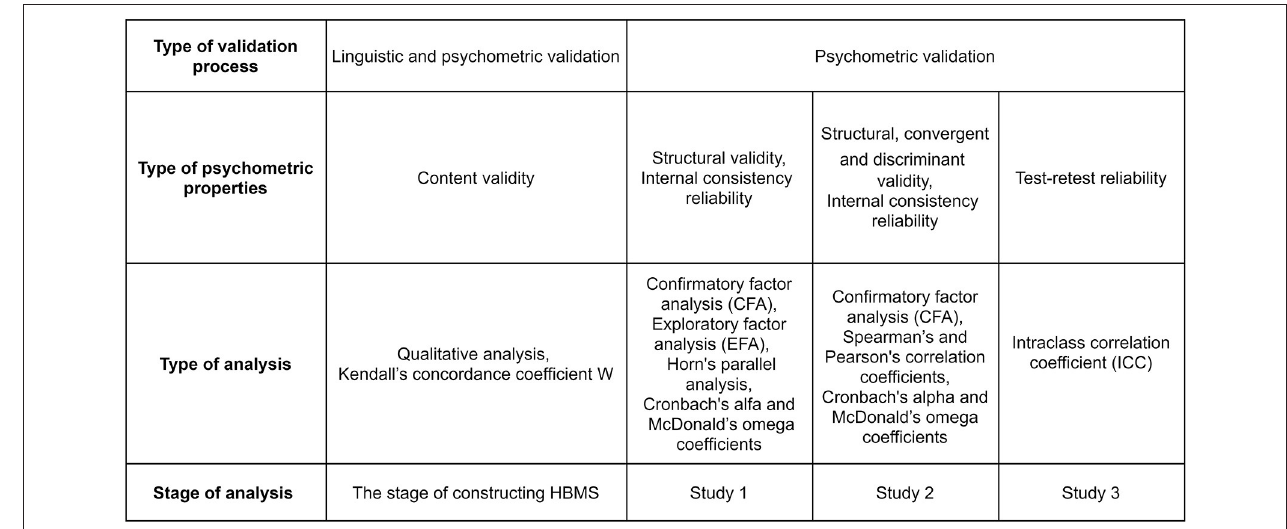
FIGURE 2 | HBMS validation procedure.